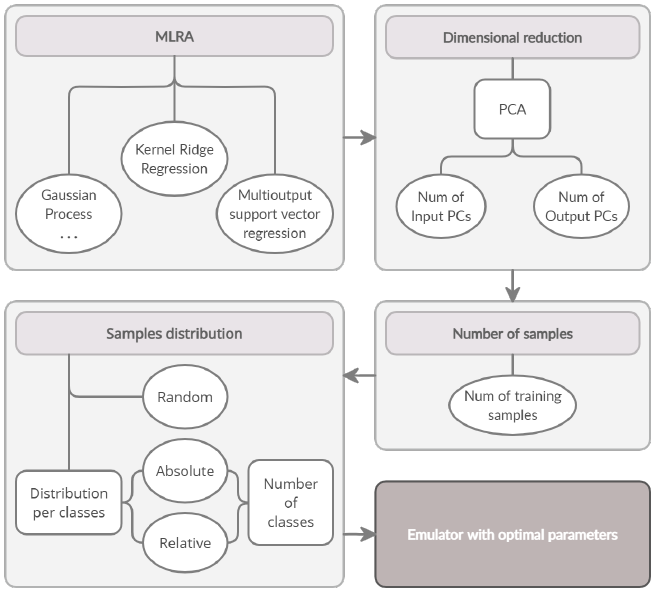
Figure 3. Flow chart showing the different parameters that were investigated to identify the optimal emulator. The grey boxes represent the analyzed parameters while the white ellipses indicate the different options tested for each parameter. The dark grey box represents the final emulator obtained with the optimal parameters of the